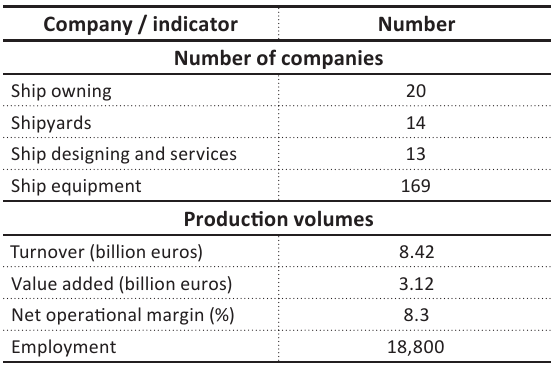
Table 1. Descriptive statistics BMC as of